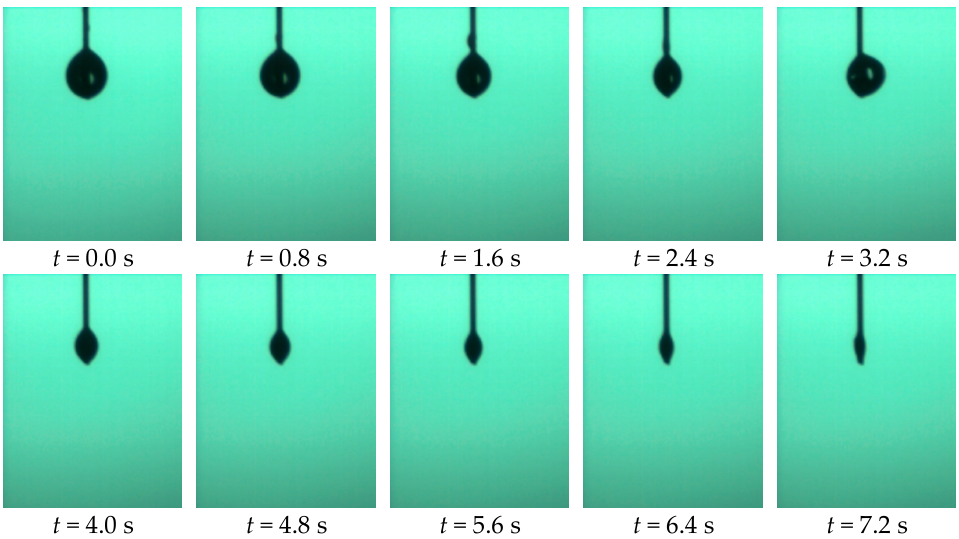
Figure 10. Normalized variation of evaporating TMEDA-based fuel droplet diameter squared with normalized time at 400 °C.